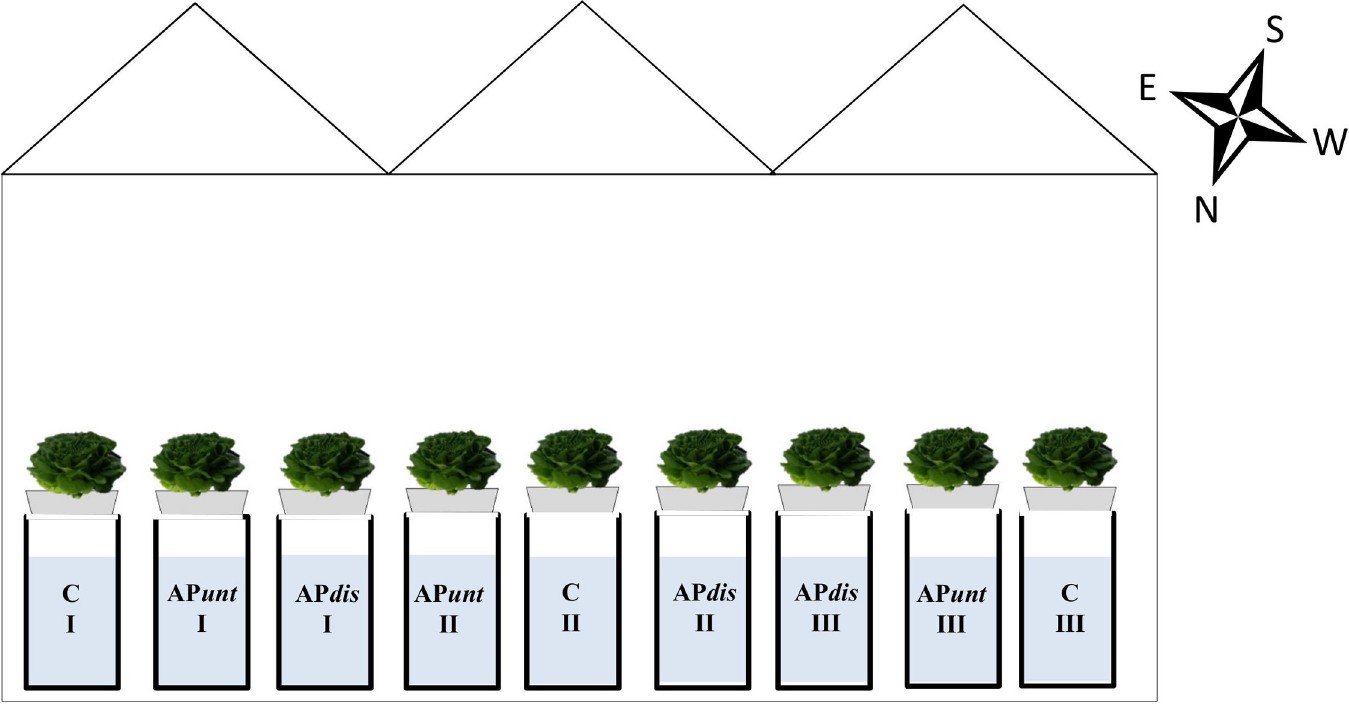
Fig 1. Schematic description of the arrangement of the experiments. C = control, fresh water based nutrient solution; AP unt —untreatend aquaponics, fish water based nutrient solution with supplemented nutrients; AP dis —like AP unt , but fish water was disinfected before use.